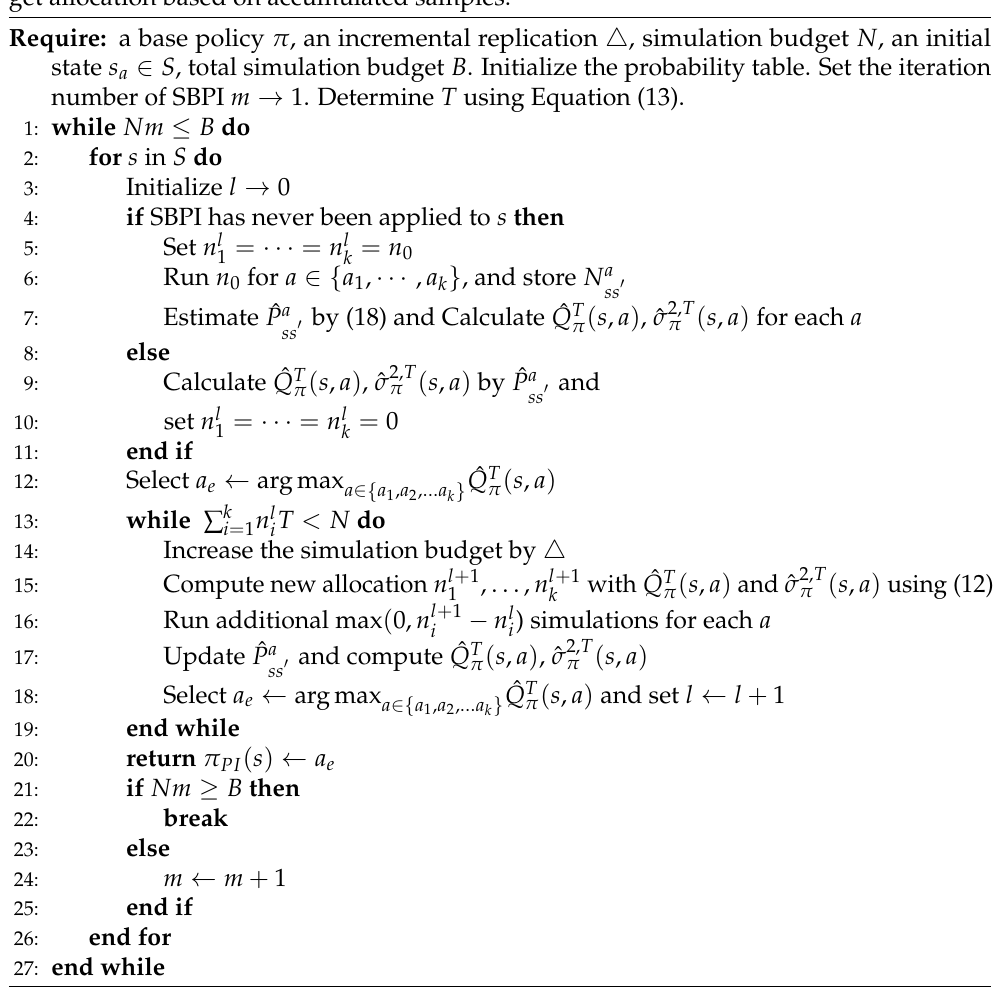
Algorithm 1 Efficient simulation-based policy improvement with optimal computing bud- get allocation based on accumulated